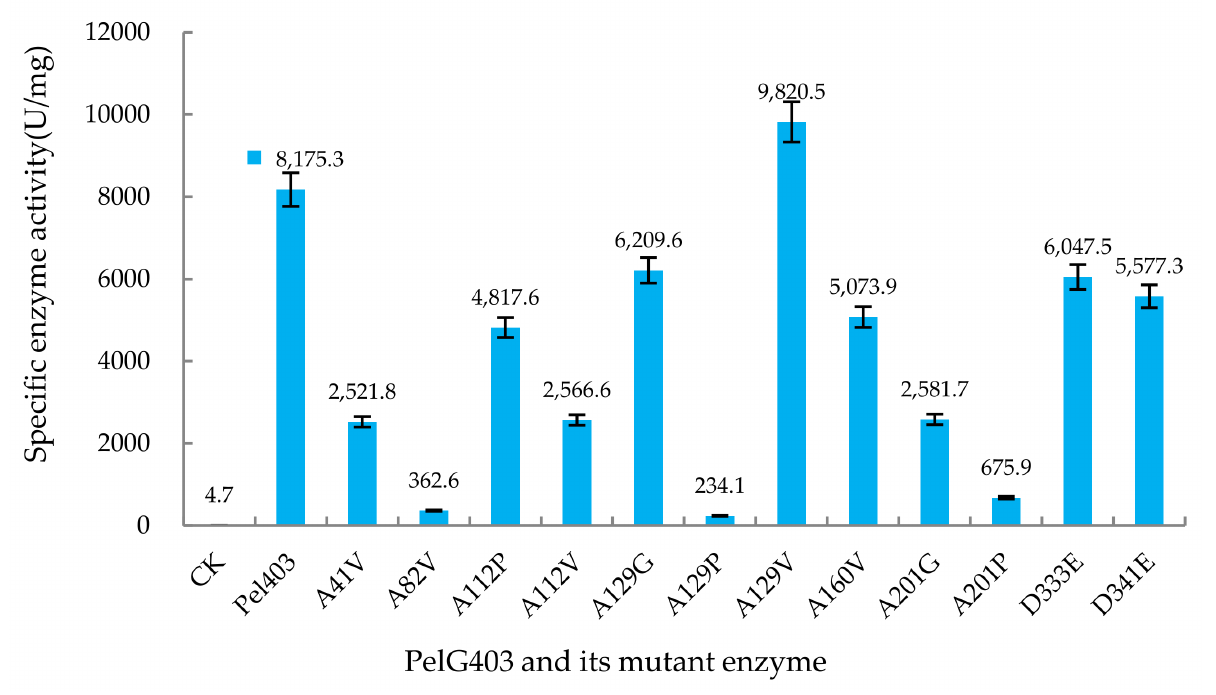
Figure 3. Pectate lyase activity of engineered bacteria. The enzyme activities of 12 mutants were measured, only A129V had specific enzymatic activity exceeding that of wild-type